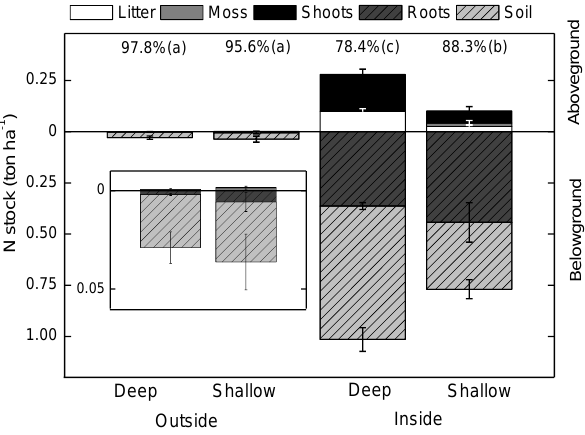
Figure 2. Mean ( ± SE) values of the biomass stock and carbon stock of litter, shoots, roots (to 30cm depth) and SOC (to 30cm depth) in four ecosystem types on Surtsey. The inserted graphs give Fig. 2. Mean (±SE) values of the nitrogen (N) stocks in litter, shoots, roots (to 30 cm depth) and 698 the values outside the seabird colony in more detail. “Shoots” in- clude aboveground living vascular plant parts. Statistical results are soil organic nitrogen (SON) (to 30 cm depth) in four ecosystem types on Surtsey. The inserted 699 shown in Table 1. Percentages above the graph indicate the % of graph gives the small N stock outside the colony in more detail. ‘Shoots’ include all aboveground 700 total N that is located belowground. Letters show statistical differ- living plant parts. Statistical results for are given in Table 1. Percentages above the graph indicate 701 the % of total N that is located belowground. Letters show statistical differences. 702